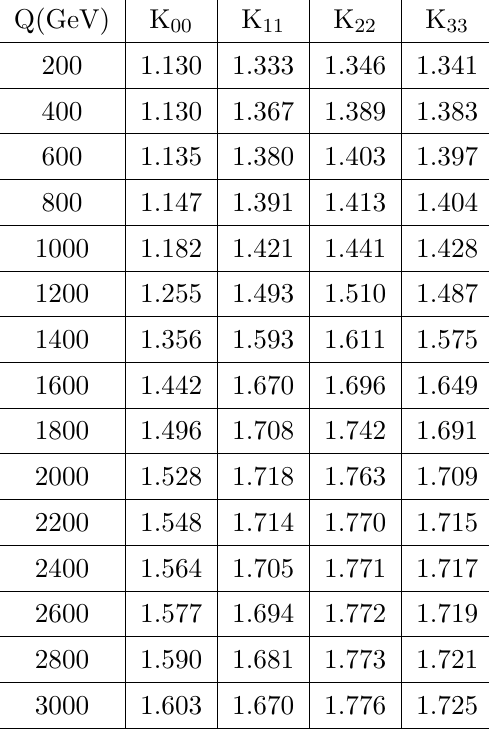
Table 4 . Resummed K-factors, de(cid:12)ned in eq. (3.5), for di-lepton invariant mass distribution at the LHC to various logarithmic accuracy.